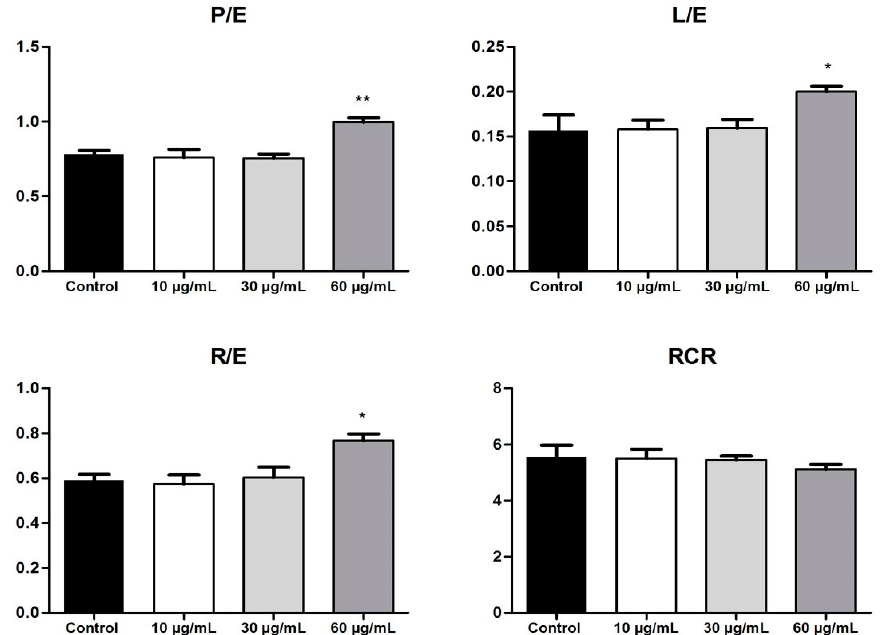
Figure 6. OB extract (10, 30, and 60 µg/mL) effects on the flux control ratios (FCRs). Data are expressed as mean ± SD. (* p < 0.05; ** p < 0.01; vs. control, calculated by one-way ANOVA, followed by a Tukey post-test). The FCRs involve the calculation of the following: (P / E) OXPHOS CI + II / ETS CI + II ; (L / E) State 2 CI / ETS CI + II ; (R / E) Routine / ETS CI + II ; and (RCR—respiratory control ratio) OXPHOS CI + II / State 4 CI + II . P / E—oxidative phosphorylation CI + II / electron transfer system CI + II ; L / E—State 2 CI / electron transfer system CI + II ; R / E—routine / electron transfer system CI + II